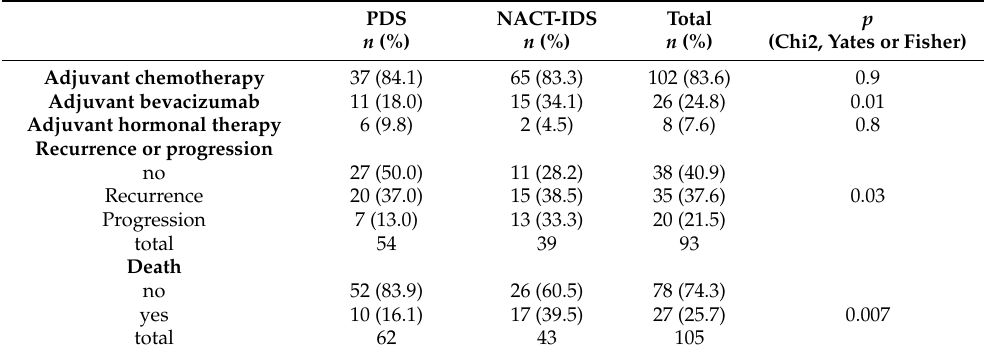
Table 4. Comparison of the PDS and NACT-IDS populations (adjuvant treatment and follow-up).